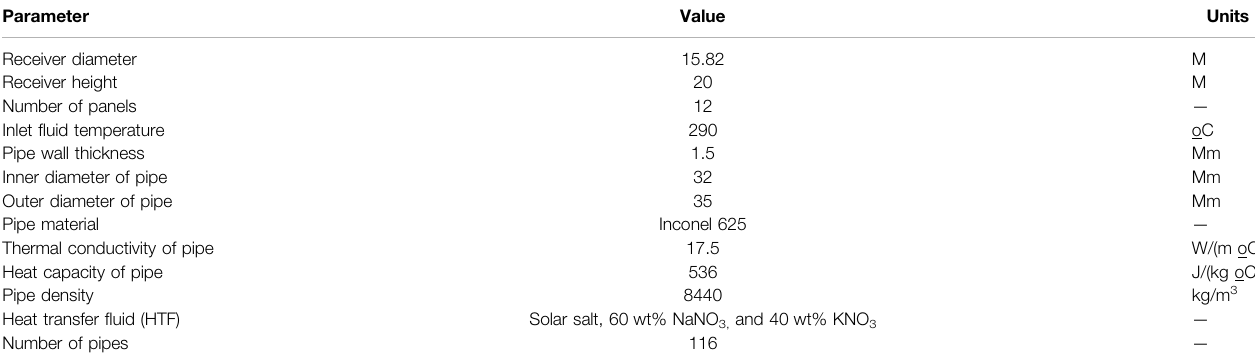
TABLE 1 | Main parameters of the central receiver.